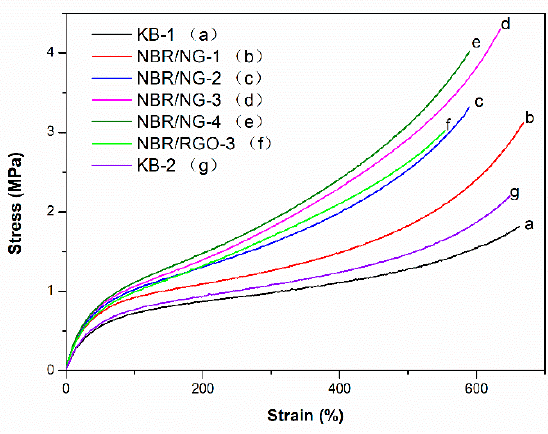
Figure 7. Stress-strain curves of NBR composites. Table 3. Mechanical properties of NBR composites.